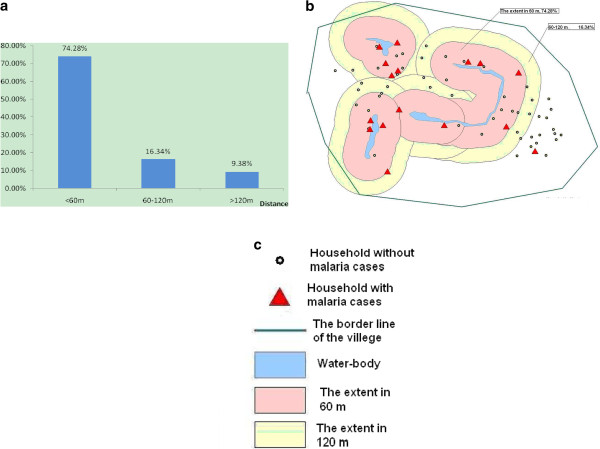
 a. The percentage of malaria cases at different distances from the water bodies. b. The general spatial characteristics of malaria cases distributed in the villages with three groups (see legend).